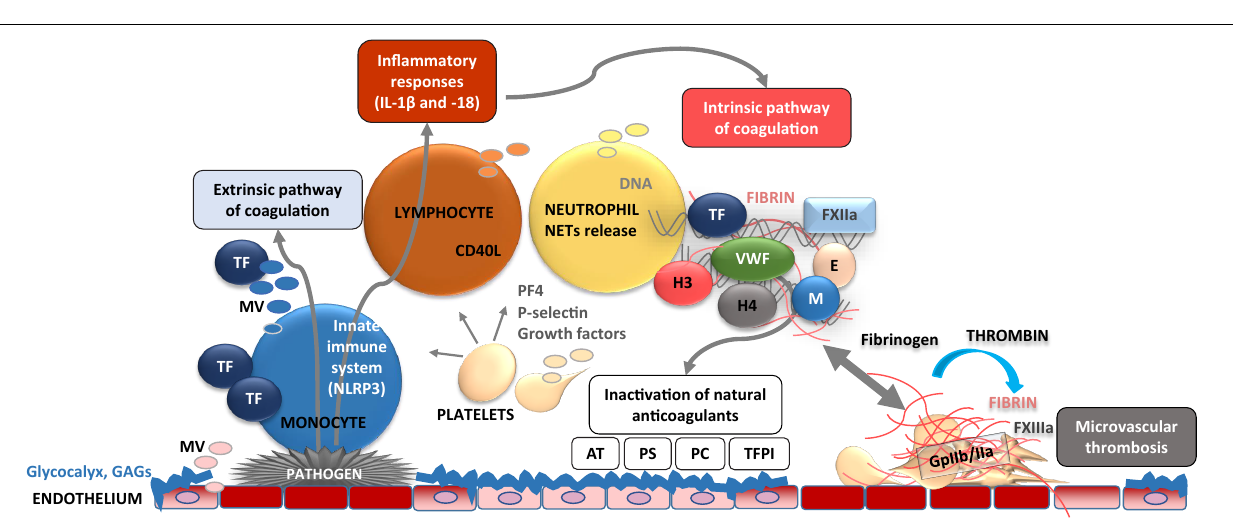
FIGURE 3 | Inflammation-triggered coagulation and thrombosis in vasculature. Upon mechanical injury or systemic inflammation of the vessel wall, activated endothelial cells and monocytes release tissue factor (TF). TF induces the generation of activated forms of coagulation factors FVII, FX, and thrombin, leading to fibrin formation. Thrombin induces the release of P-selectin, which binds to P-selectin glycoprotein ligand-1 (PSGL-1) on neutrophils, monocytes and lymphocytes mediating their tethering and rolling on to the exposed endothelium. The release of procoagulant platelet factor 4 (PF4) and von Willebrand factor (VWF) promote the recruitment, adhesion, and activation of platelets and leukocytes at the injury site. Thrombin cleaves fibrinogen to form fibrin, which stabilizes thrombosis. The firm adhesion of leukocytes to fibrin occurs via CD11b/18 α M β 2, macrophage-1 antigen (MAC-1) or complement receptor 3 (CR3).